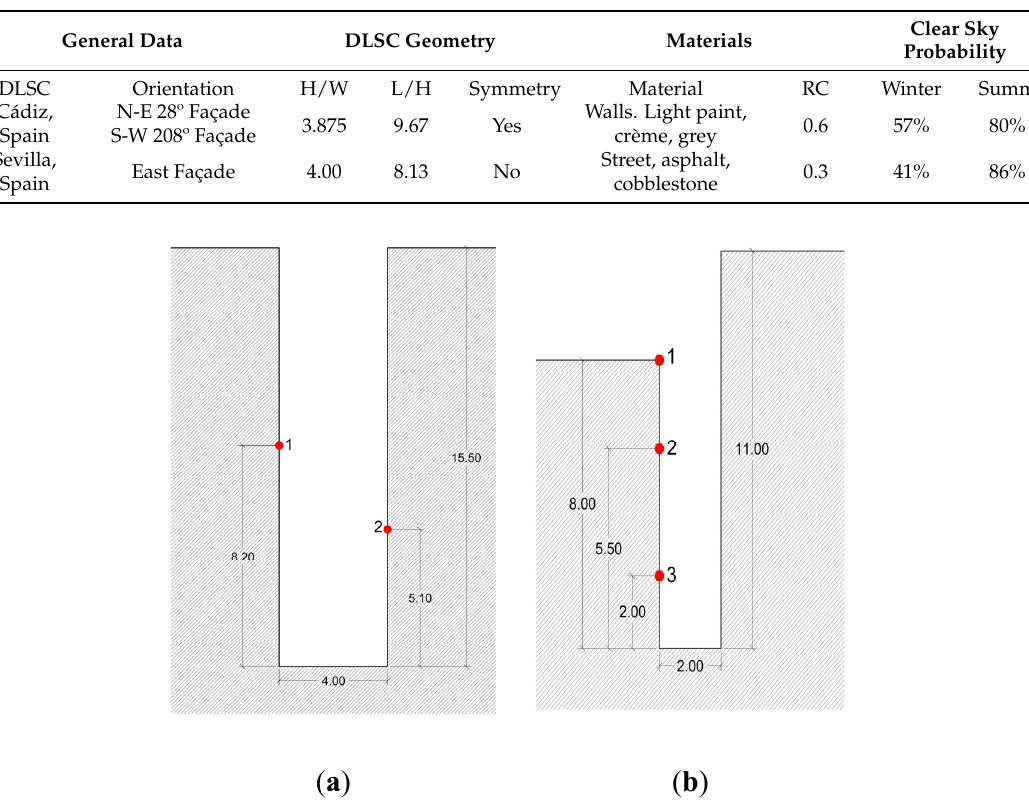
Figure 6. Cell measurements location in Deep Long Street Canyons ( a ) Cadiz. 28º North-East façade at 8.20 m (1). 208º South-West façade at 5.10 m (2); ( b ) Seville East façade at 8.00 m (1), 5.50 m (2) and 2.00 m (3).